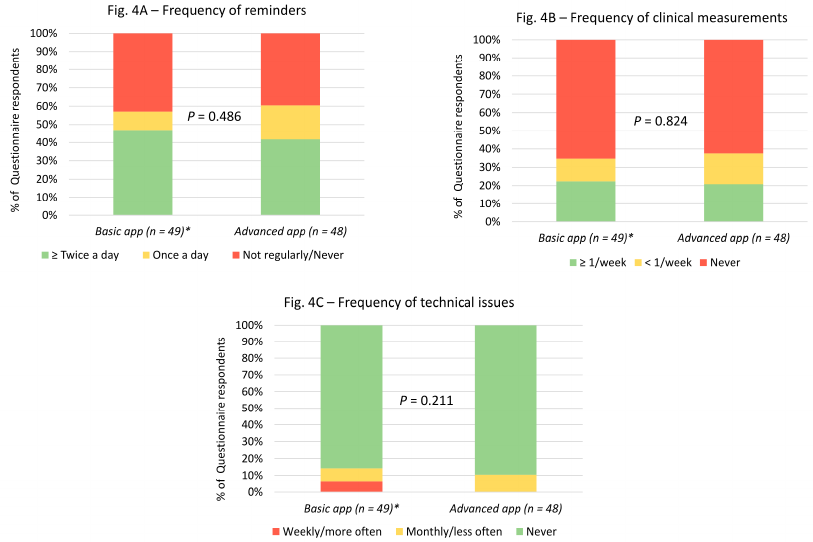
Figure 4. Engagement-related questionnaire responses in both basic and advanced app groups. *1 missing response in the basic medication reminder app